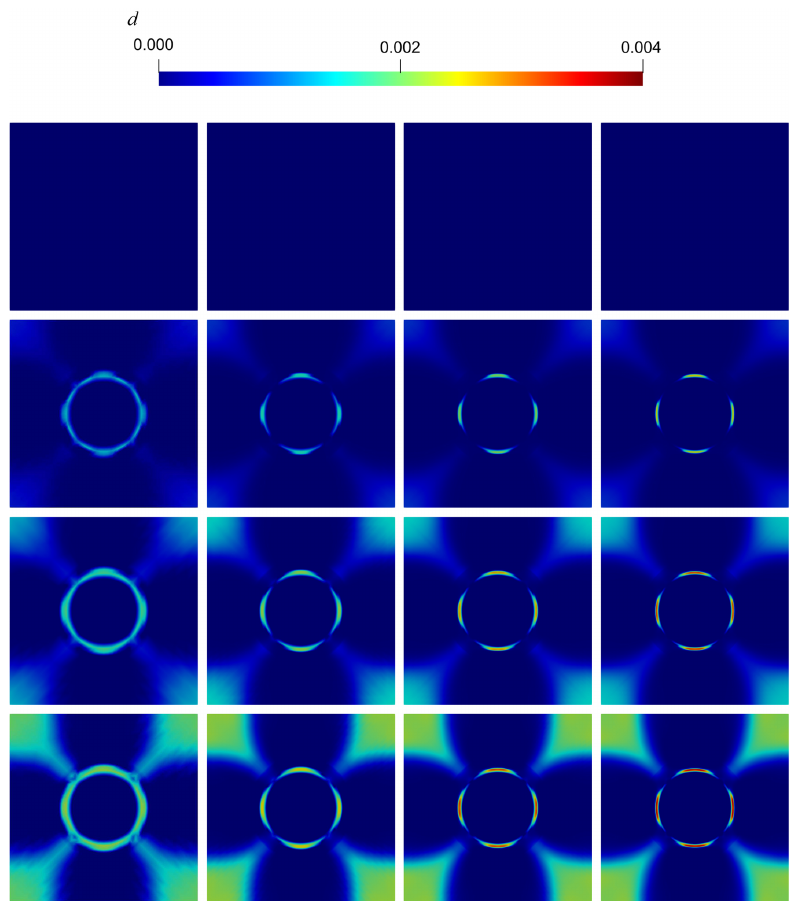
Figure 8: Shear: distribution of damage 𝑑 for 1024, 3136, 6400 and 10,816 elements (from left to right) for steps 150, 255, 270, and 290